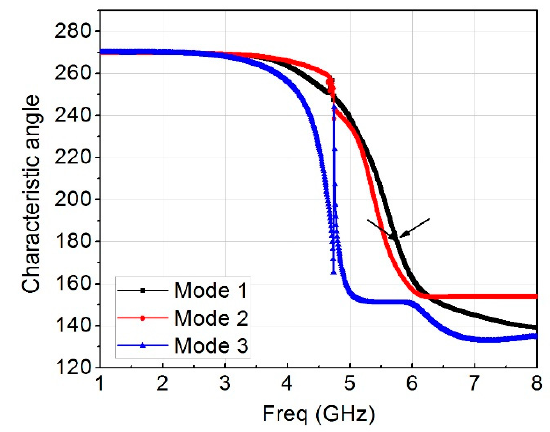
Figure 13. Characteristic angle of three modes at 5.8 GHz.